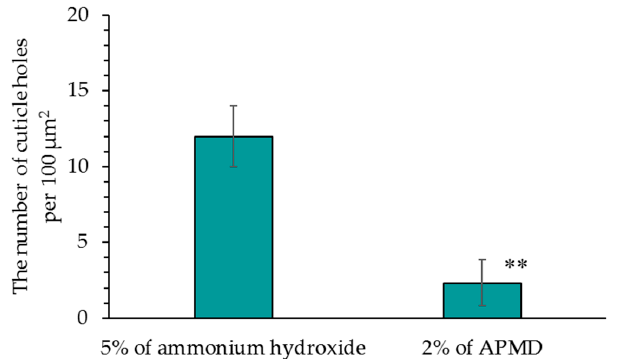
Figure 8. Comparison of the number of cuticle holes in FE-SEM images (×10,000). The results are expressed as the mean ± standard deviation of three experiments. ** p < 0.01 vs. ammonium hydroxide.